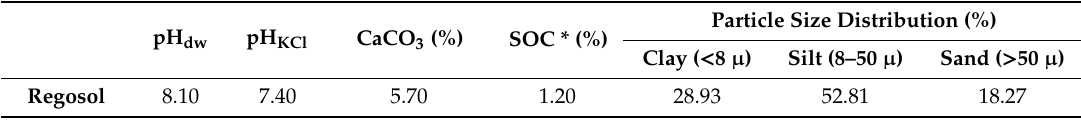
Table 1. Main properties of the examined topsoil (0–30 cm